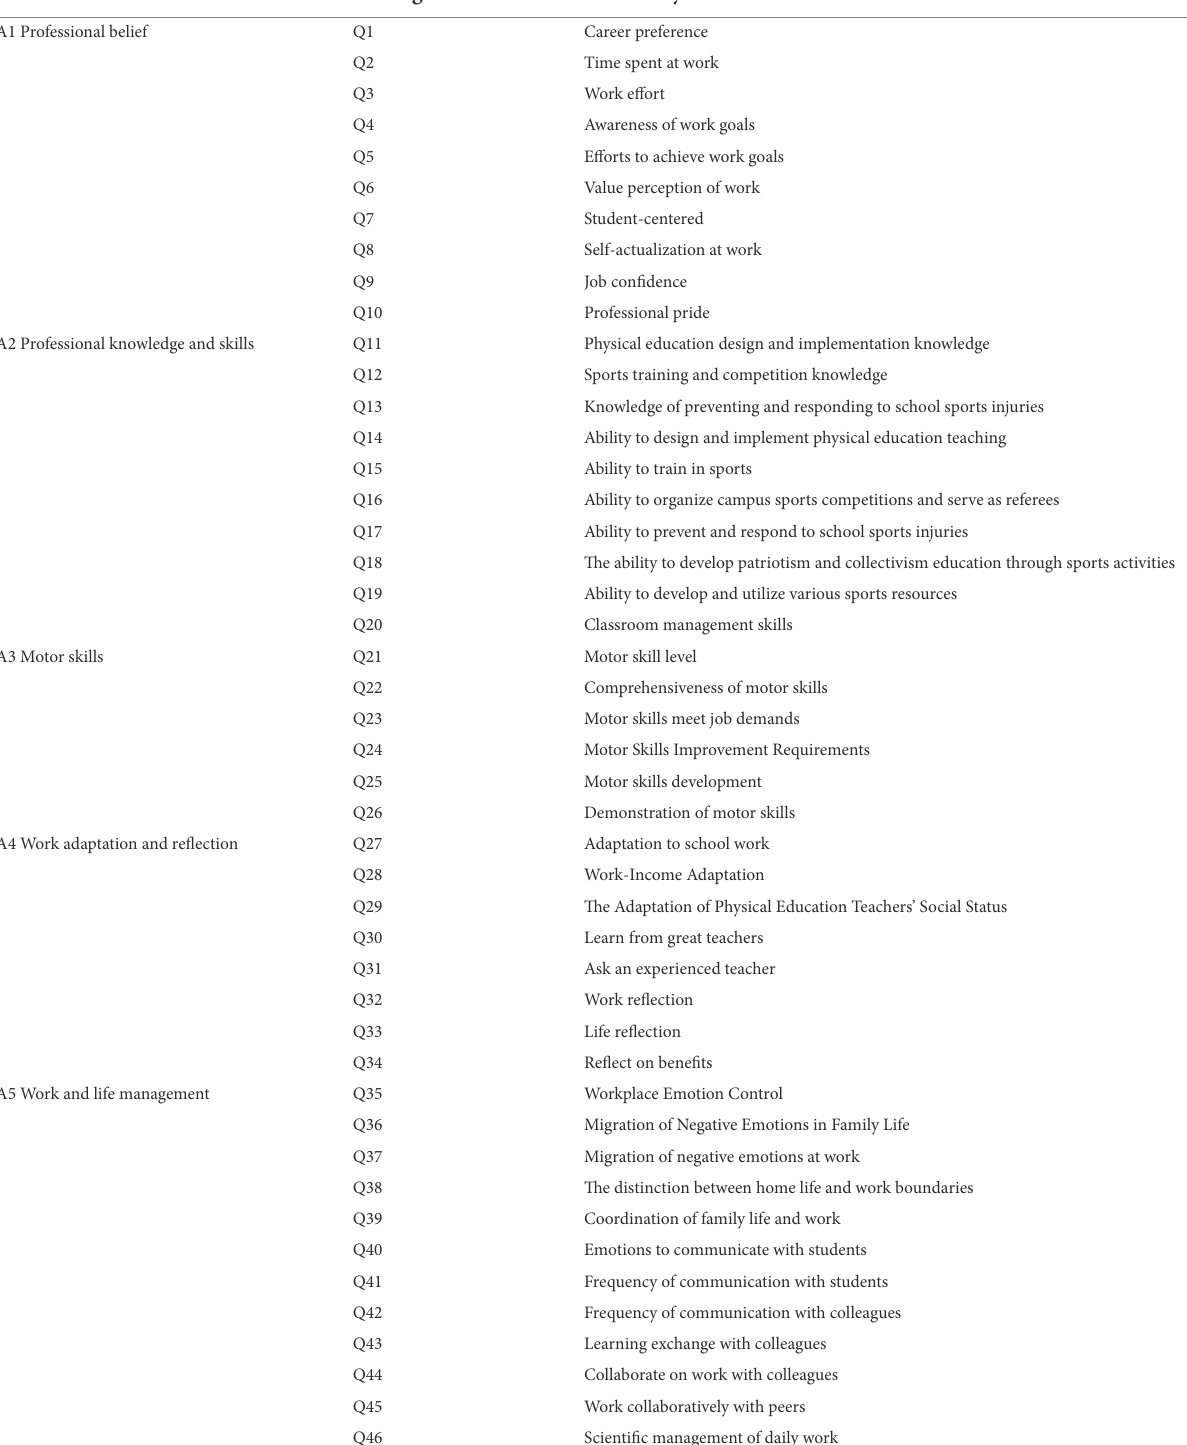
TABLE 2 TCLQ-PPE initial indicator